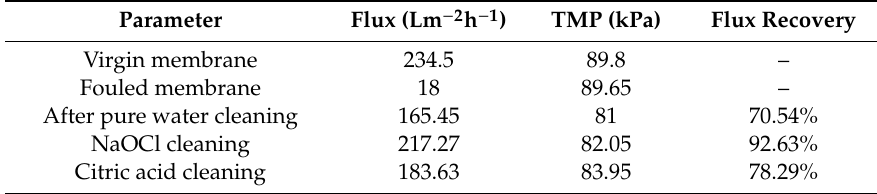
Table 4. The flux recovery of the ceramic membrane after chemical